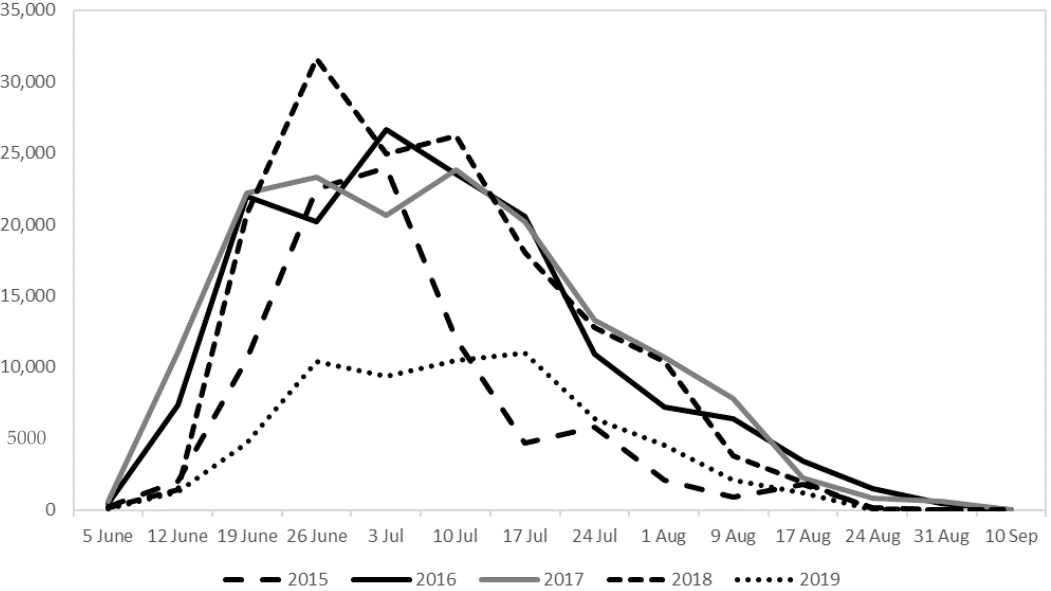
Figure 2. Total number of adults male of Thaumetopoea pityocampa collected with the pheromone-baited traps in the five-year period. (Data collected always refers to 277 traps, except for 2015 when the traps were 135).